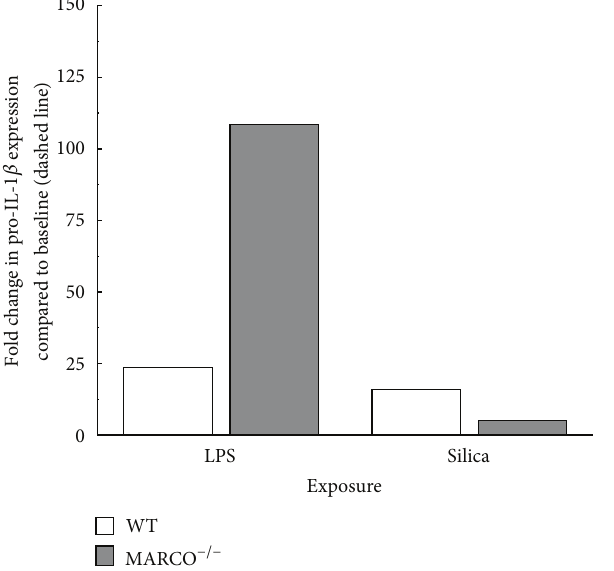
Figure 5: Pro-IL-1 𝛽 mRNA expression in WT and MARCO −/− AM analyzed using RT-PCR. White bars indicate WT AM and grey bars indicate MARCO −/− AM. Fold change in pro-IL-1 𝛽 expression was compared to unstimulated control. The data represent one experiment with 2 replications.